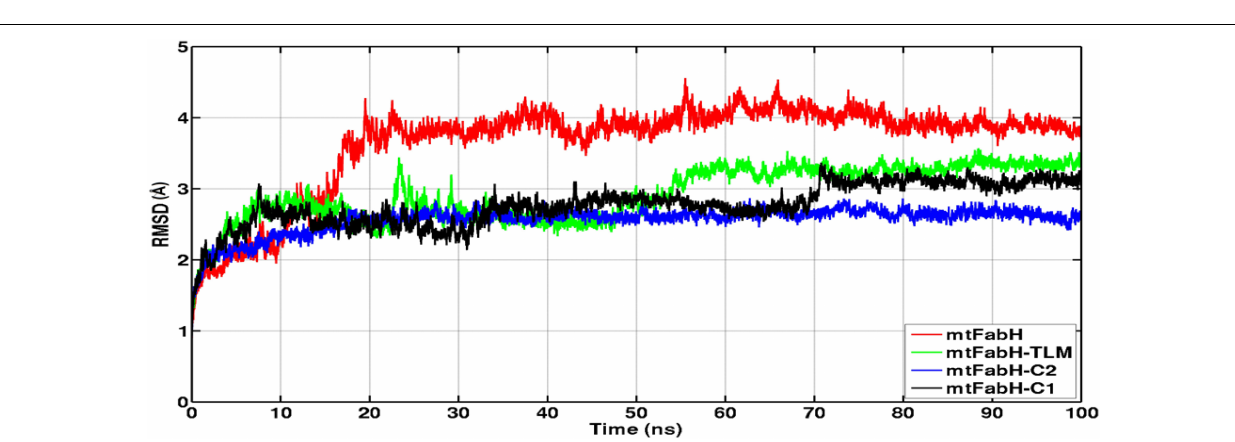
FIGURE 8 | Time evolution plots of C α -backbone RMSD of mtFabH (red), mtFabH-TLM complex (green), mtFabH-C2 (blue), and mtFabH-C1 (black). The MD trajectories were plotted using